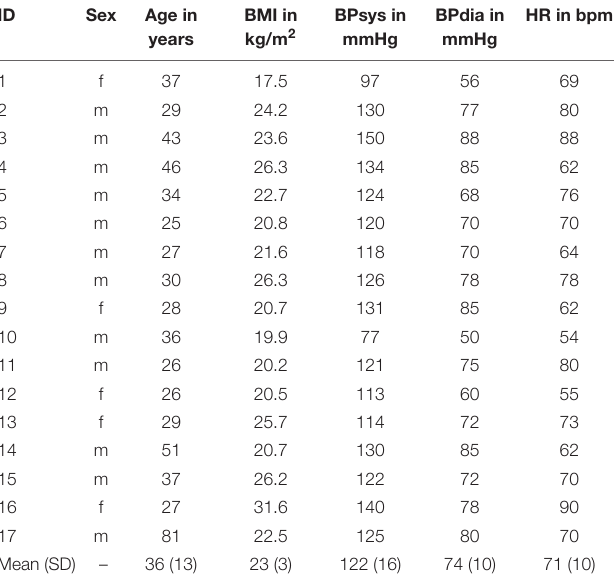
TABLE 1 | Participant characteristics with abbreviations: body mass index (BMI), systolic blood pressure (BPsys), diastolic blood pressure (BPdis), and heart rate (HR).